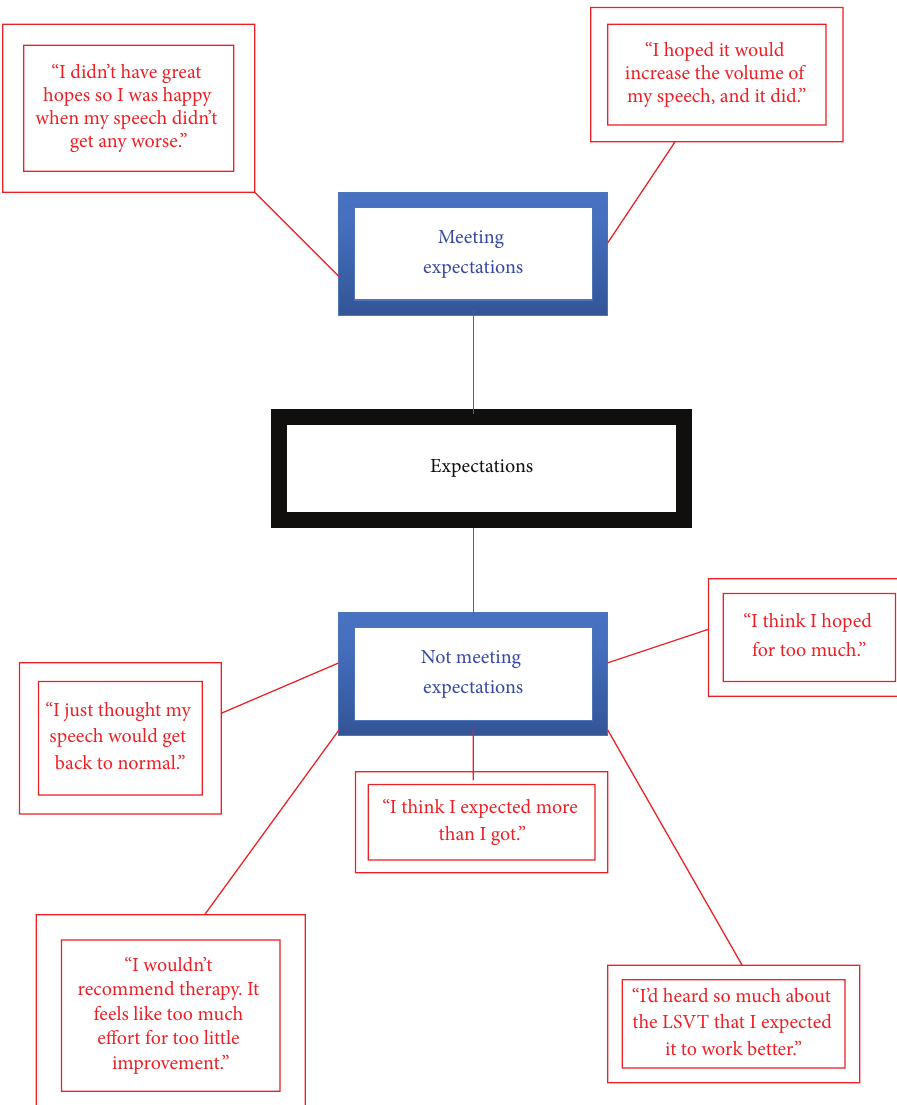
Figure 4: Thematic Network Analysis: